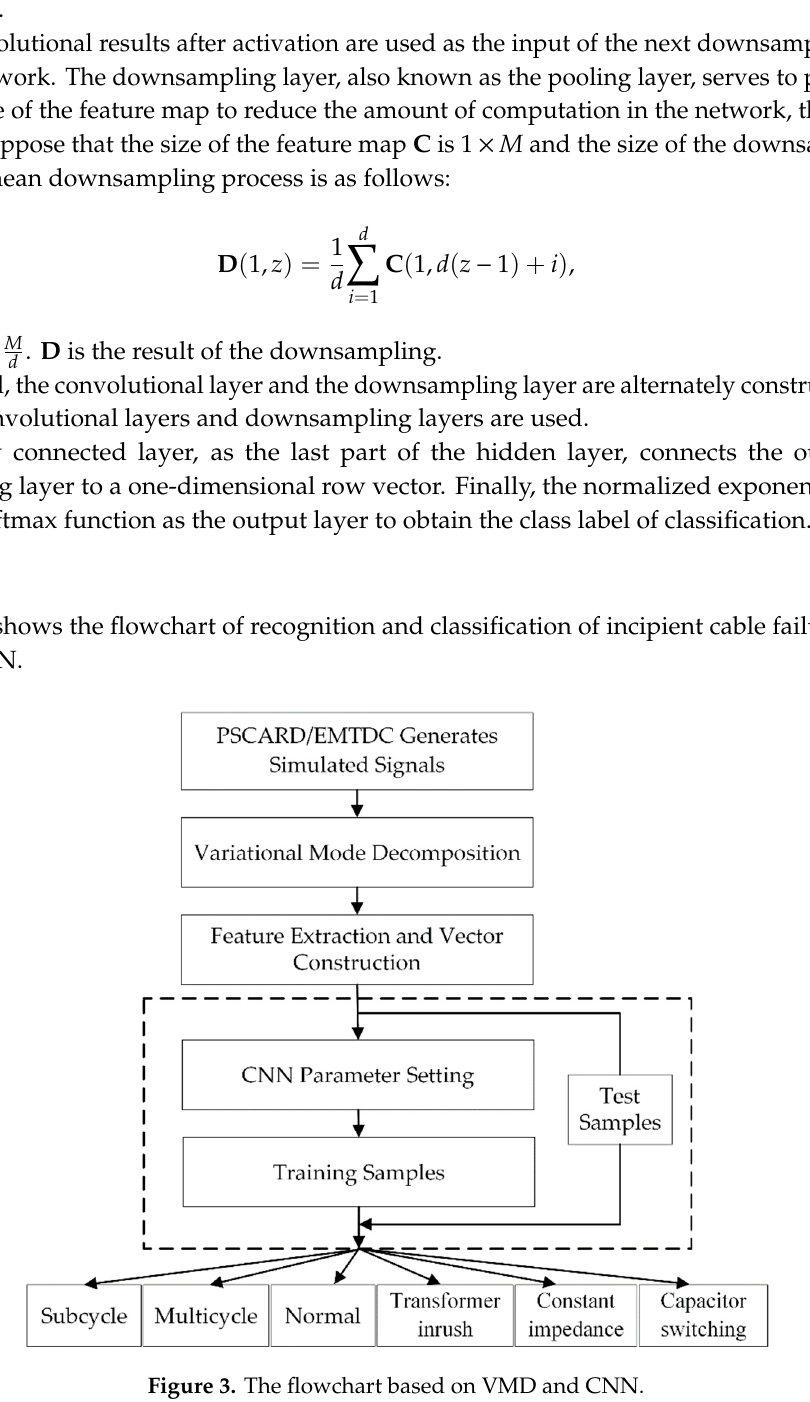
Figure 3. The flowchart based on VMD and CNN.